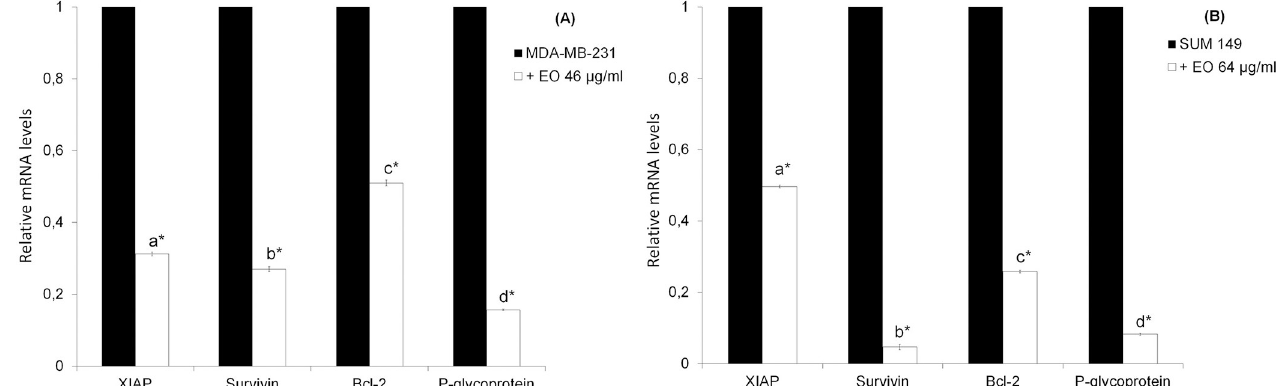
Fig 4. Genes mRNA expression levels by quantitative polymerase chain reaction in MDA-MB-231 cells (A) and SUM 149 cells (B). The cells were treated for 24 h with C . juttae essential oil (EO) (46 and 64 μ g/ml, respectively). Data are expressed as mean ± standard error (SE) of two different experiments. Different letters (a, b, c and d) in the column of the cell lines and treatments represent significant differences (p < 0.05) among the treatments of each cell line; � differences when treatments are compared to the control (p < 0.05).